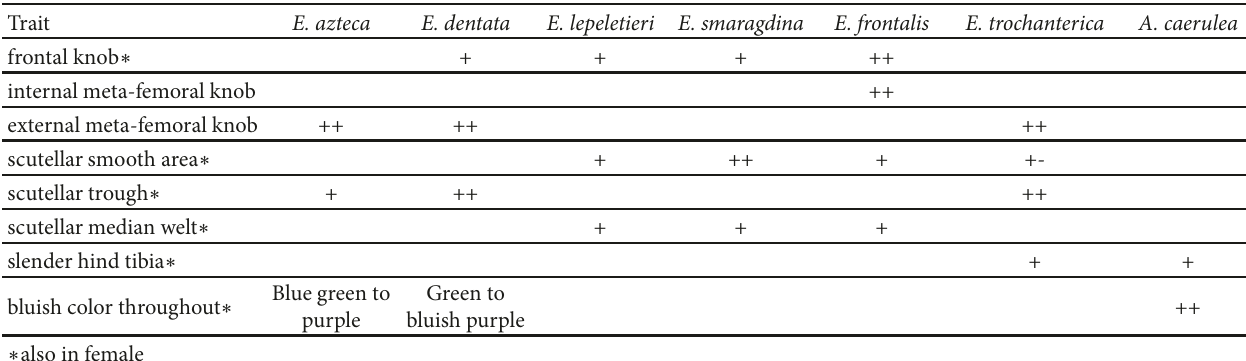
Table 2: Diagnostic traits for species identification with the microscope. Sampling area as in Table